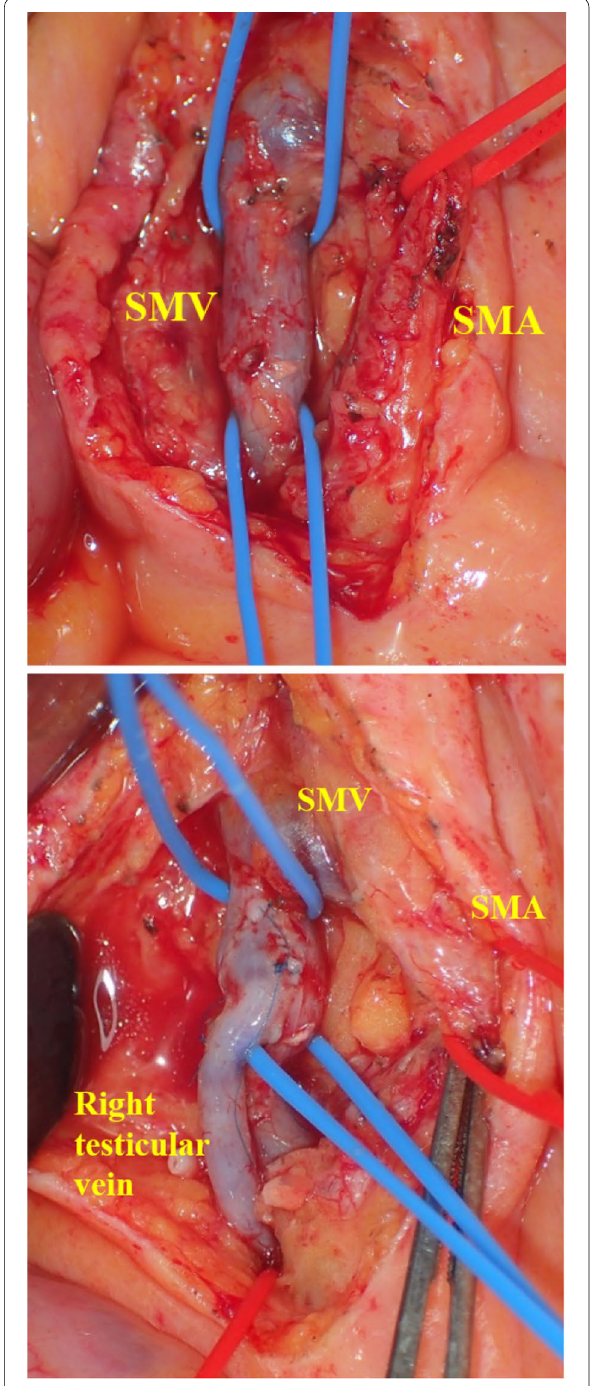
Fig. 4 Operative findings. We performed an end-to-side anastomosis between the right testicular vein and superior mesenteric vein. Dilatation of the right testicular vein was healthy after the anastomosis